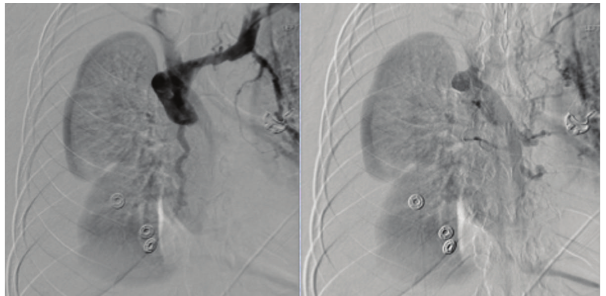
Figure 1: Initial EGD with extensive esophageal varices from the mid to distal esophagus.